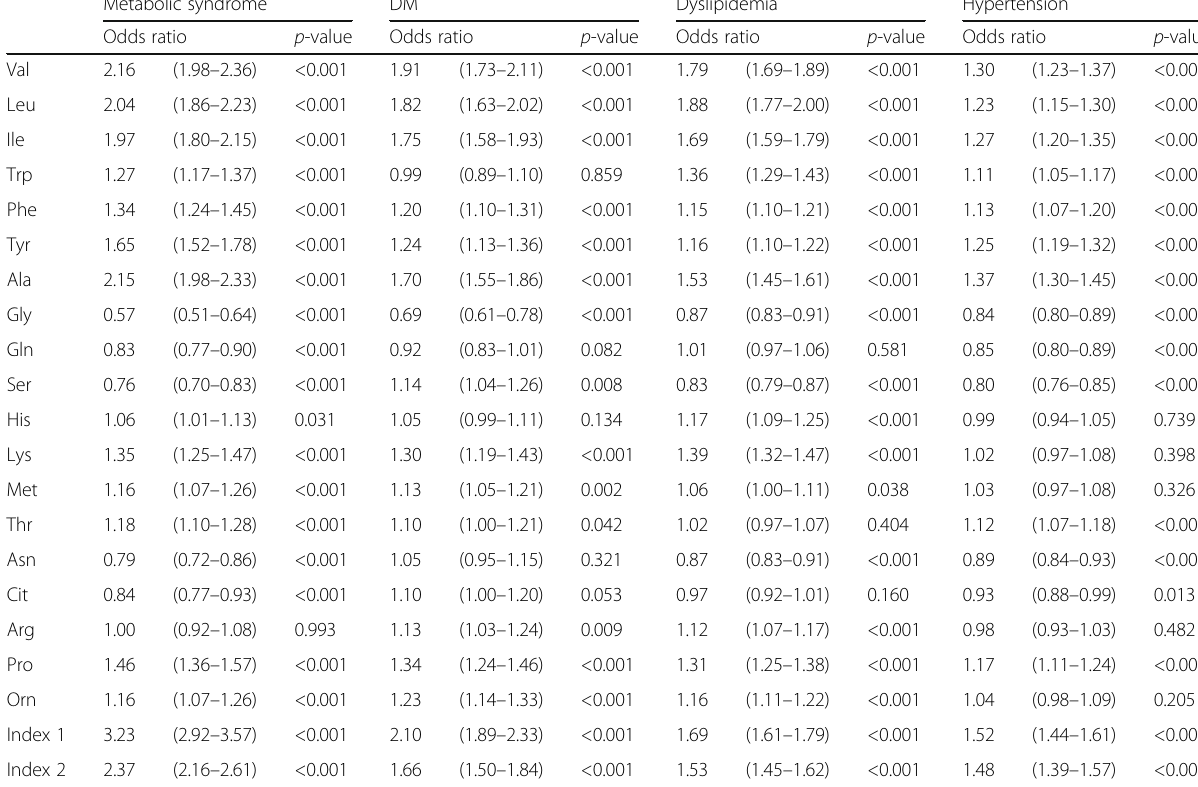
Table 4 The odds ratios for evaluating metabolic syndrome, DM, dyslipidemia, or hypertension adjusting for age and gender Metabolic syndrome